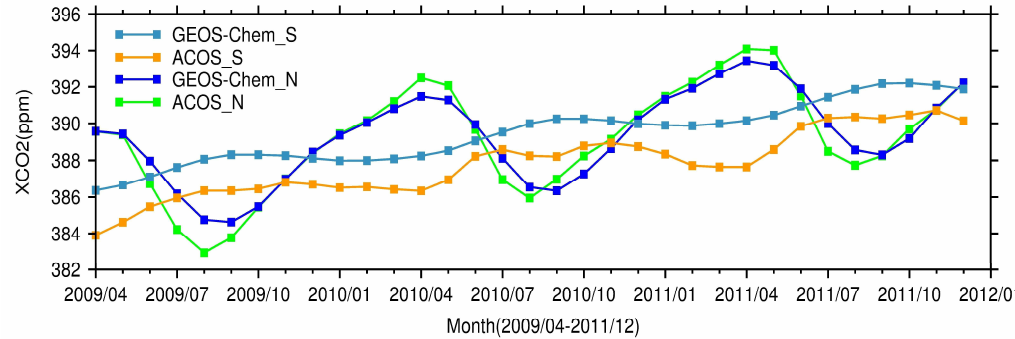
Figure 4. The time series variations of monthly averaged XCO 2 for April 2009–December 2011 in the NH and SH between GOSAT/ACOS and GEOS-Chem. The green line denote the GOSAT/ACOS XCO 2 retrievals in the NH and the orange one is in the SH; the two blue lines refers to the XCO 2 simulated from GEOS-Chem in the NH and SH respectively.